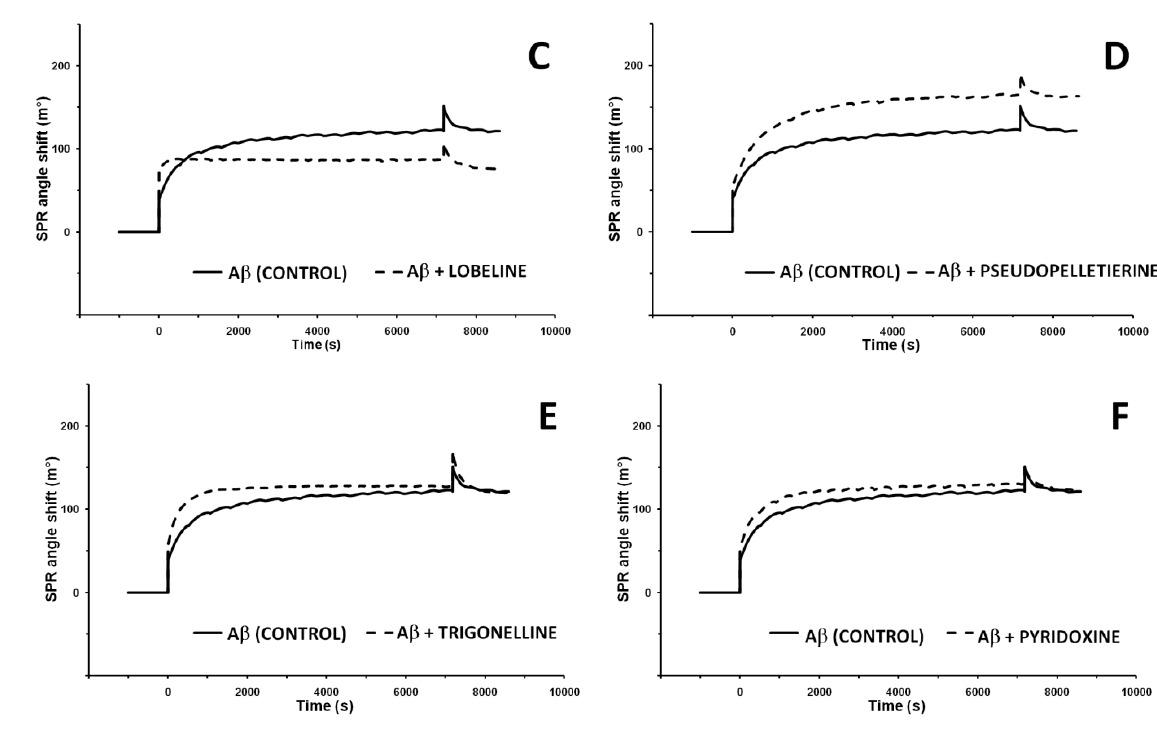
Figure 5. SPR angle shift values for Aβ